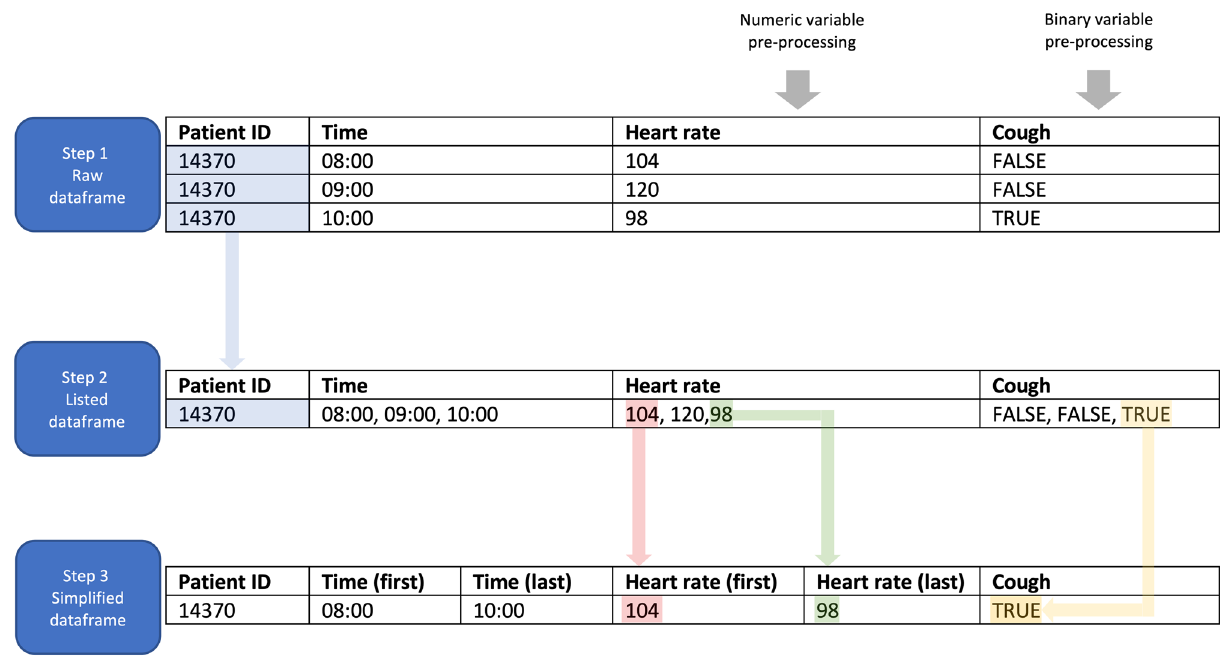
order, with a single row per ID (blue arrow). In the third step , data were simplified. For numeric variables, only the first value was selected (red arrow). For binary variables, the value “true” was retained when it was present at least once in the list (yellow